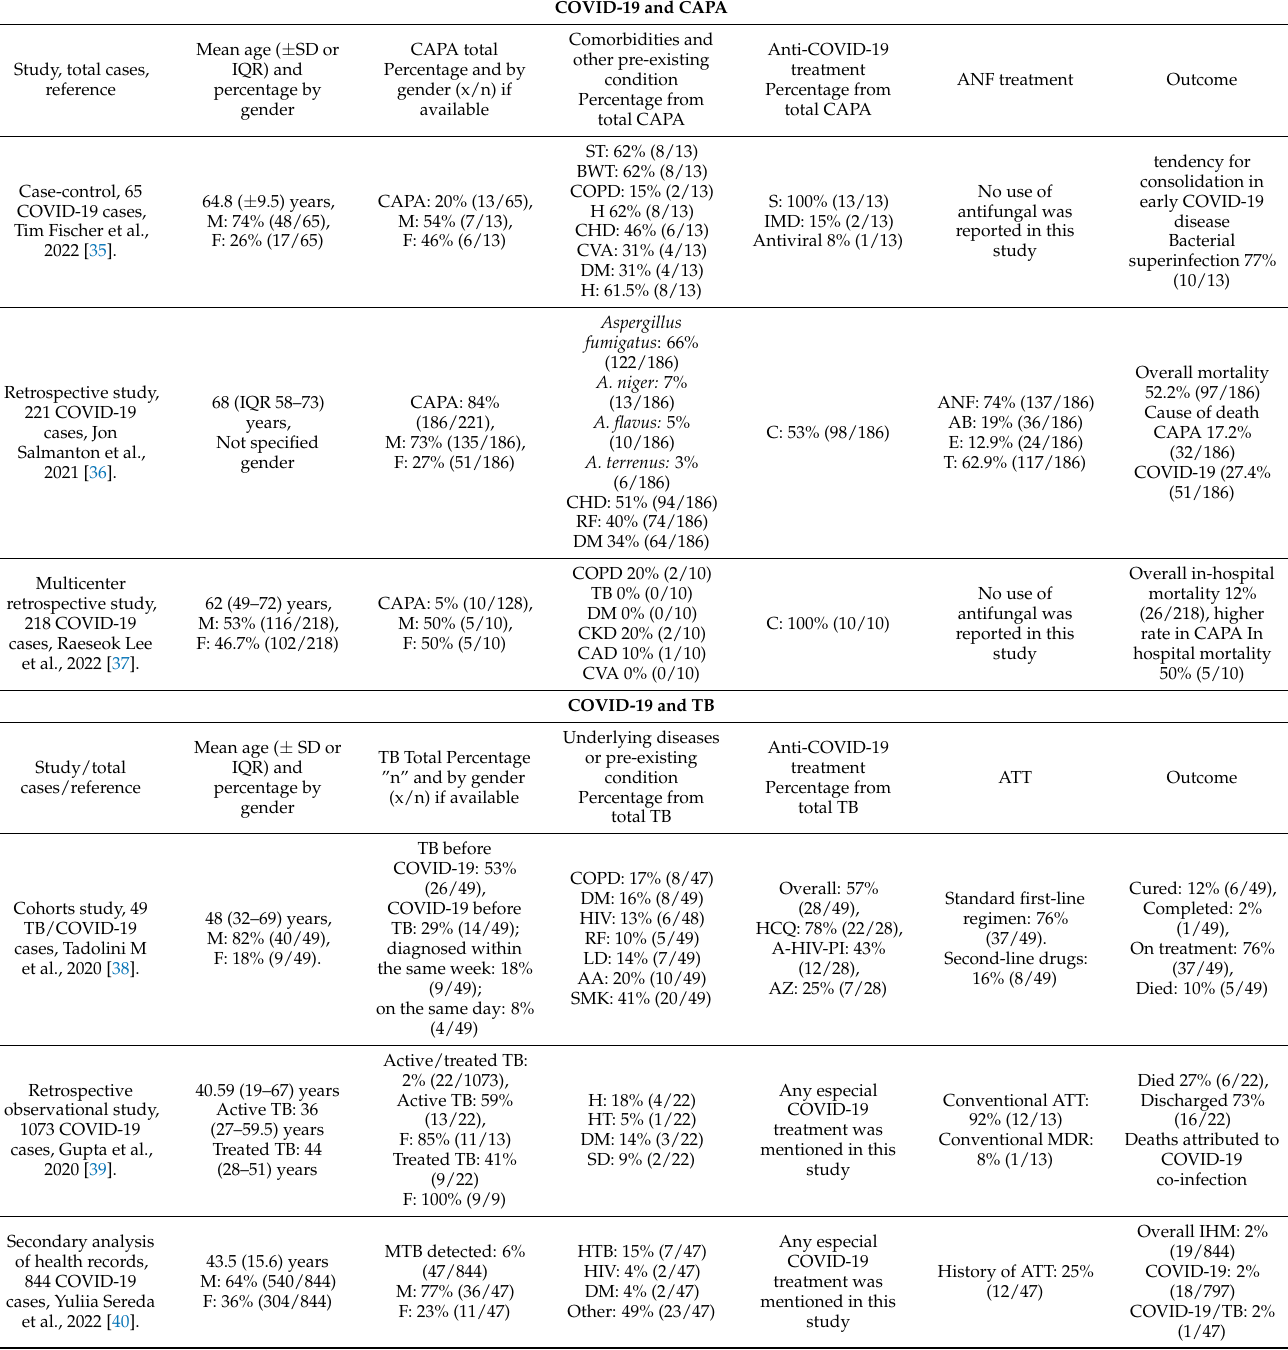
Table 1. Summary of studies reporting COVID-19 and CAPA or COVID-19 and